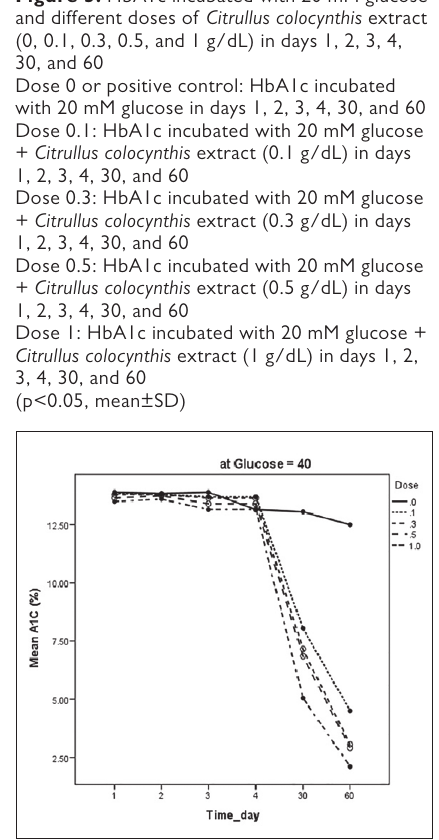
Figure 2. HbA1c incubated with 10 mM glucose and different doses of Citrullus colocynthis extract (0, 0.1, 0.3, 0.5, and 1 g/dL) in days 1, 2, 3, 4, 30, and 60 Dose 0 or positive control: HbA1c incubated with 10 mM glucose in days 1, 2, 3, 4, 30, and 60